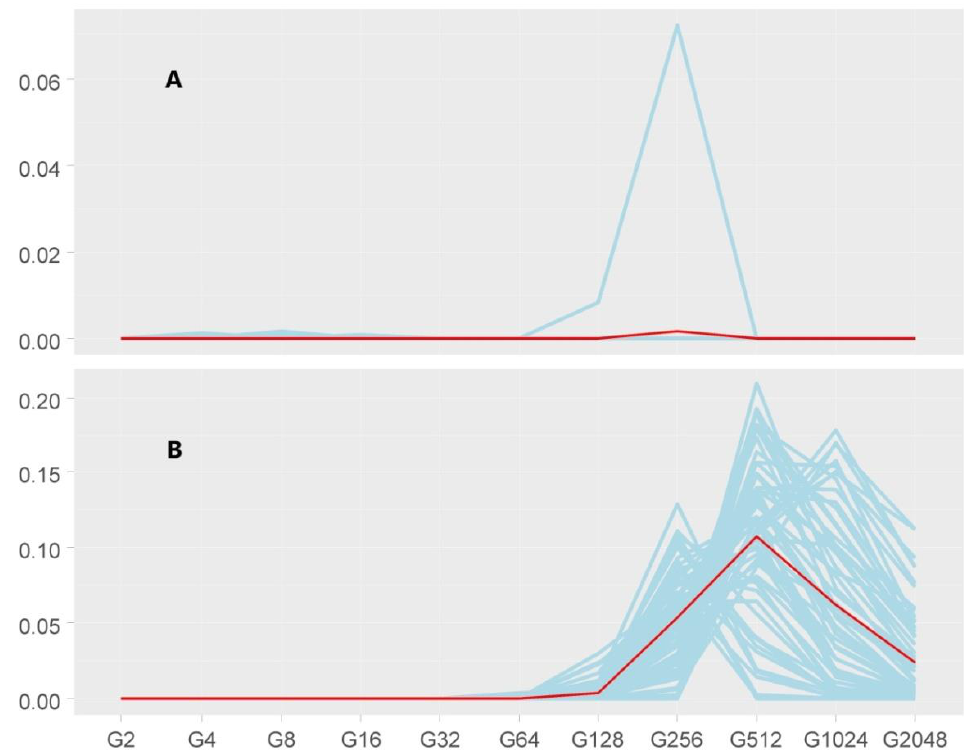
Figure 4. Genomic inbreeding coe ffi cients estimated with respect to di ff erent base populations (in 11 generation classes from G2 to G2048) estimated as the probability of a given genomic segment belonging to any of the 11 homozygosity-by-descent (HBD) classes fitted. ( A ) The variation in genomic inbreeding of individuals with no HBD segments assigned to G1024 or G2048. ( B ) The same variation for the individuals harboring HBD segments kept for enrichment analyses. Dark lines are the average values for each subpopulation. Note that ( A ) and ( B ) have di ff erent ranges on the Y-axis.